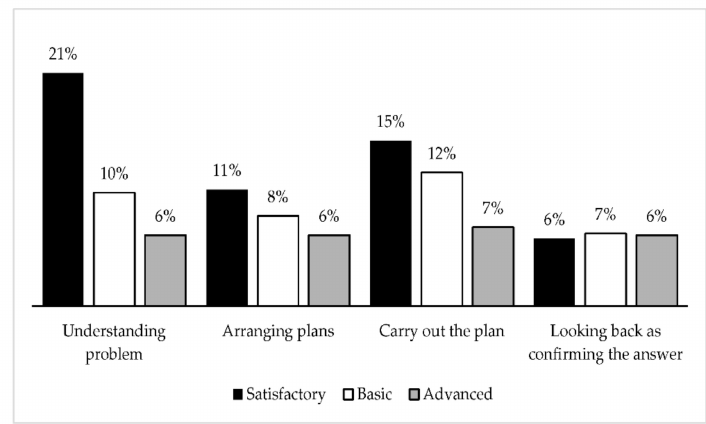
Figure 3. Primary schoolchildren problem-solving abilities